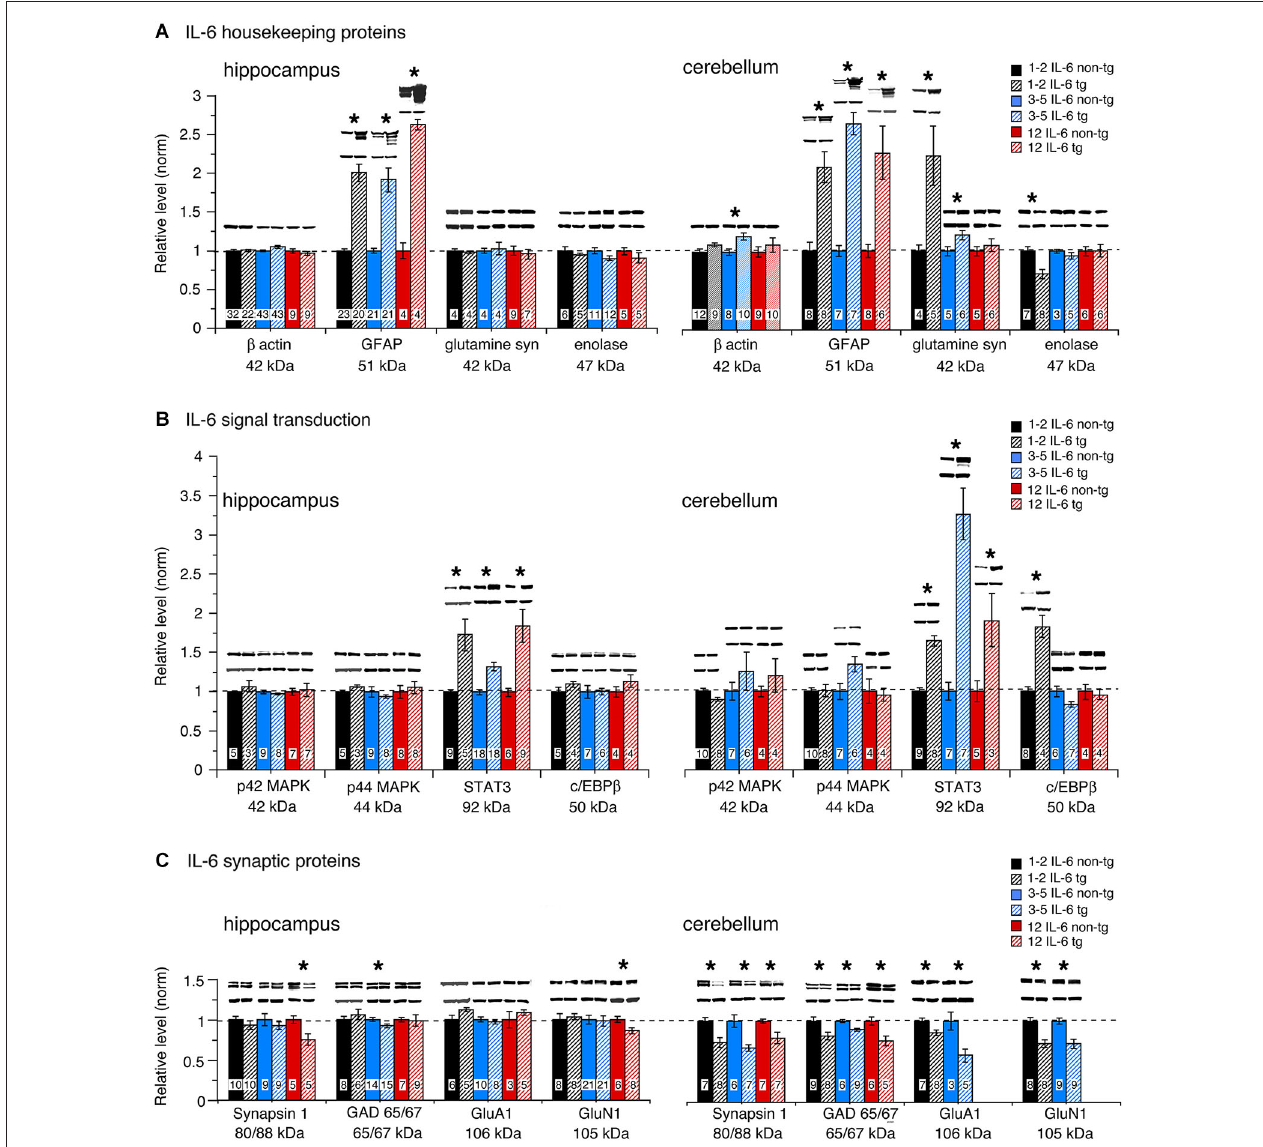
blots are shown above the respective bar. Top blot is the protein indicated for the graph; bottom blot is β actin in the same lane. Numbers in bars are the number of animals measured. * = statistically significant difference between IL-6 tg and non-tg for the age